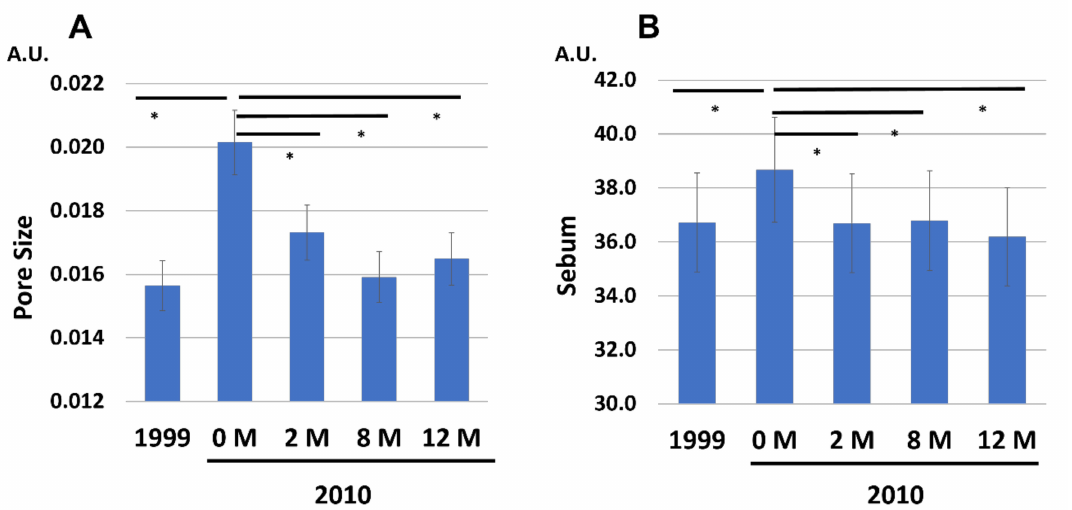
Figure 11. Chronological facial skin measurements in 1999 and in 2010 (at 0, 2, 8, and 12 M). All 86 subjects were treated with twice-daily application of G3 product formula for 12 M (0 M to 12 M). ( A ) Pore size. ( B ) Sebum production. * p < 0.05.